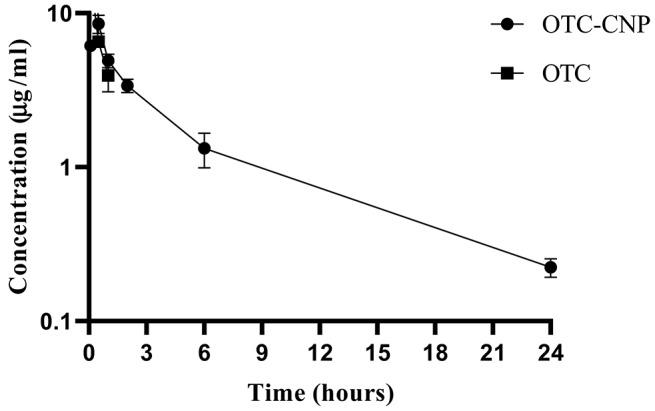
Semilogarithmic (means ± SD) plot of OTC plasma concentration following intraperitoneal (IP) administrations of OTC-CNP and OTC at the dose of 10 mg/kg in BALB/c mice (n = 5).